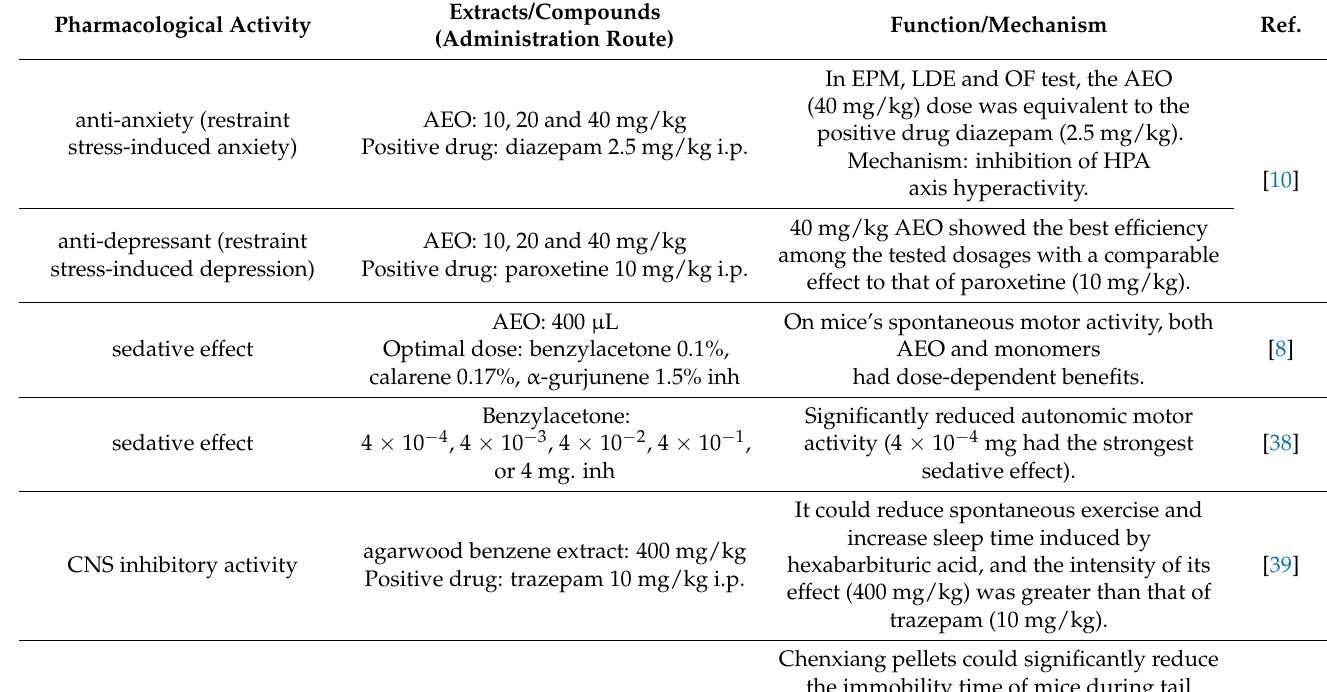
Table 2. Summary of the sedative and tranquilizing pharmacological activity experiments of agarwood. Pharmacological